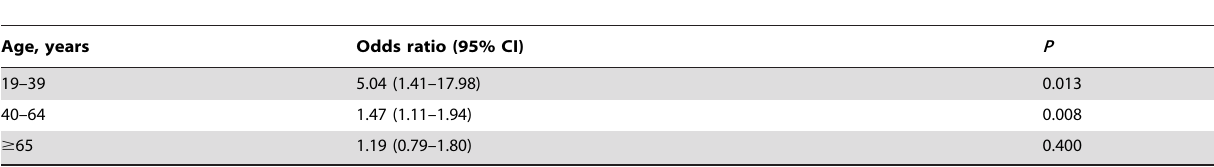
Table 6. Odds ratio for lens opacity by the presence of diabetes in different age